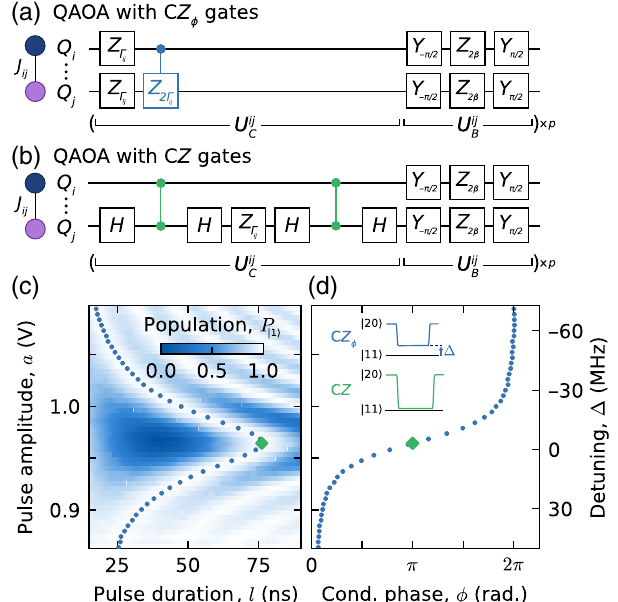
FIG. 1. (a) Quantum circuit of a layer q of QAOA for the two-qubit subspace | Q i Q j (cid:4) , using the controlled arbitrary-phase gate (blue) to rotate the | 11 (cid:4) state by an angle 2 (cid:4) ij where (cid:4) ij = 2 γ q J ij . (b) A QAOA layer with the phase-separation unitary decomposed into C Z gates (green) and additional Hadamard U ij C gates and single-qubit Z -gates. (c) Excited-state population P | 1 (cid:4) of the higher-frequency qubit Q i = A 1 brought in interaction with the lower-frequency qubit Q j = B 2 via a flux pulse (all qubits are operated at their maximal frequency). We perform a two-dimensional sweep of flux-pulse amplitude a and flux- pulse duration l , and indicate the maximum population recovery with blue dots. P | 1 (cid:4) is extracted using a three-level readout (see Appendix A). (d) Conditional phase for the dots indicated in (c). The green diamond corresponds to the C Z gate. The right axis indicates the detuning between | 11 (cid:4) and | 20 (cid:4) . The inset depicts the shift in frequency of the bare | 20 (cid:4) state relative to the bare | 11 (cid:4) state during the flux pulse for the C Z φ gate and the C Z gate, see Appendix B for more